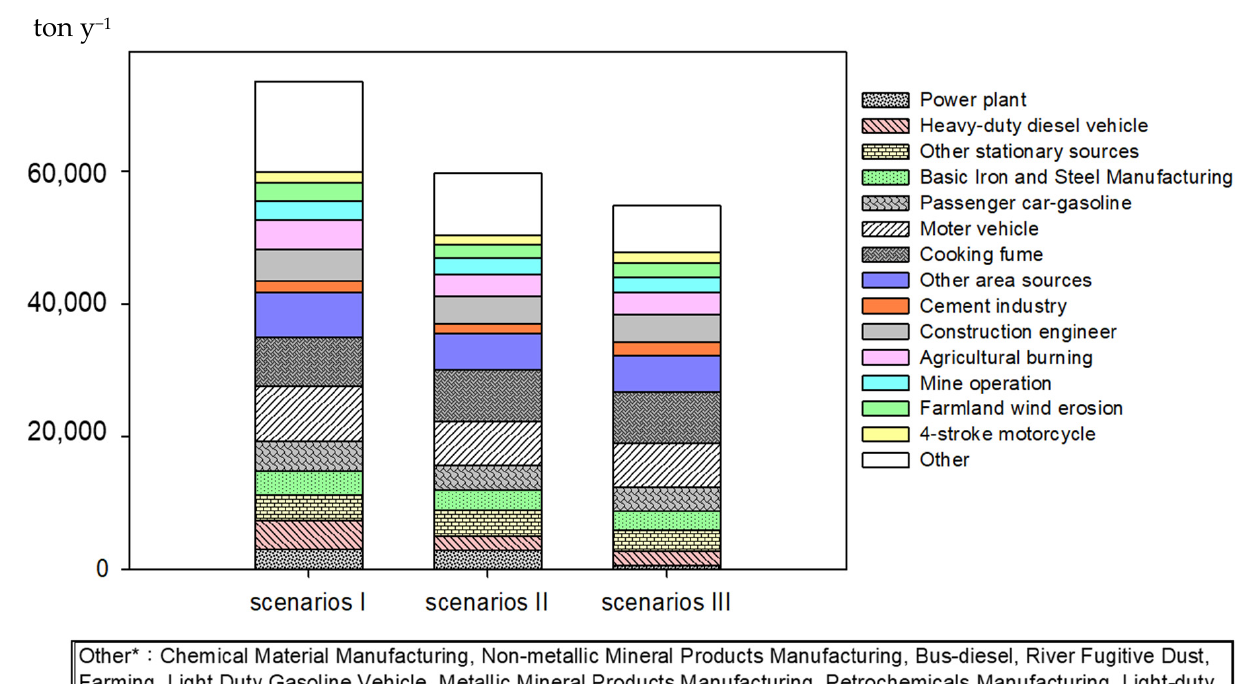
Figure 5. PM 2.5 emission sources for different scenarios (ton y − 1 ).